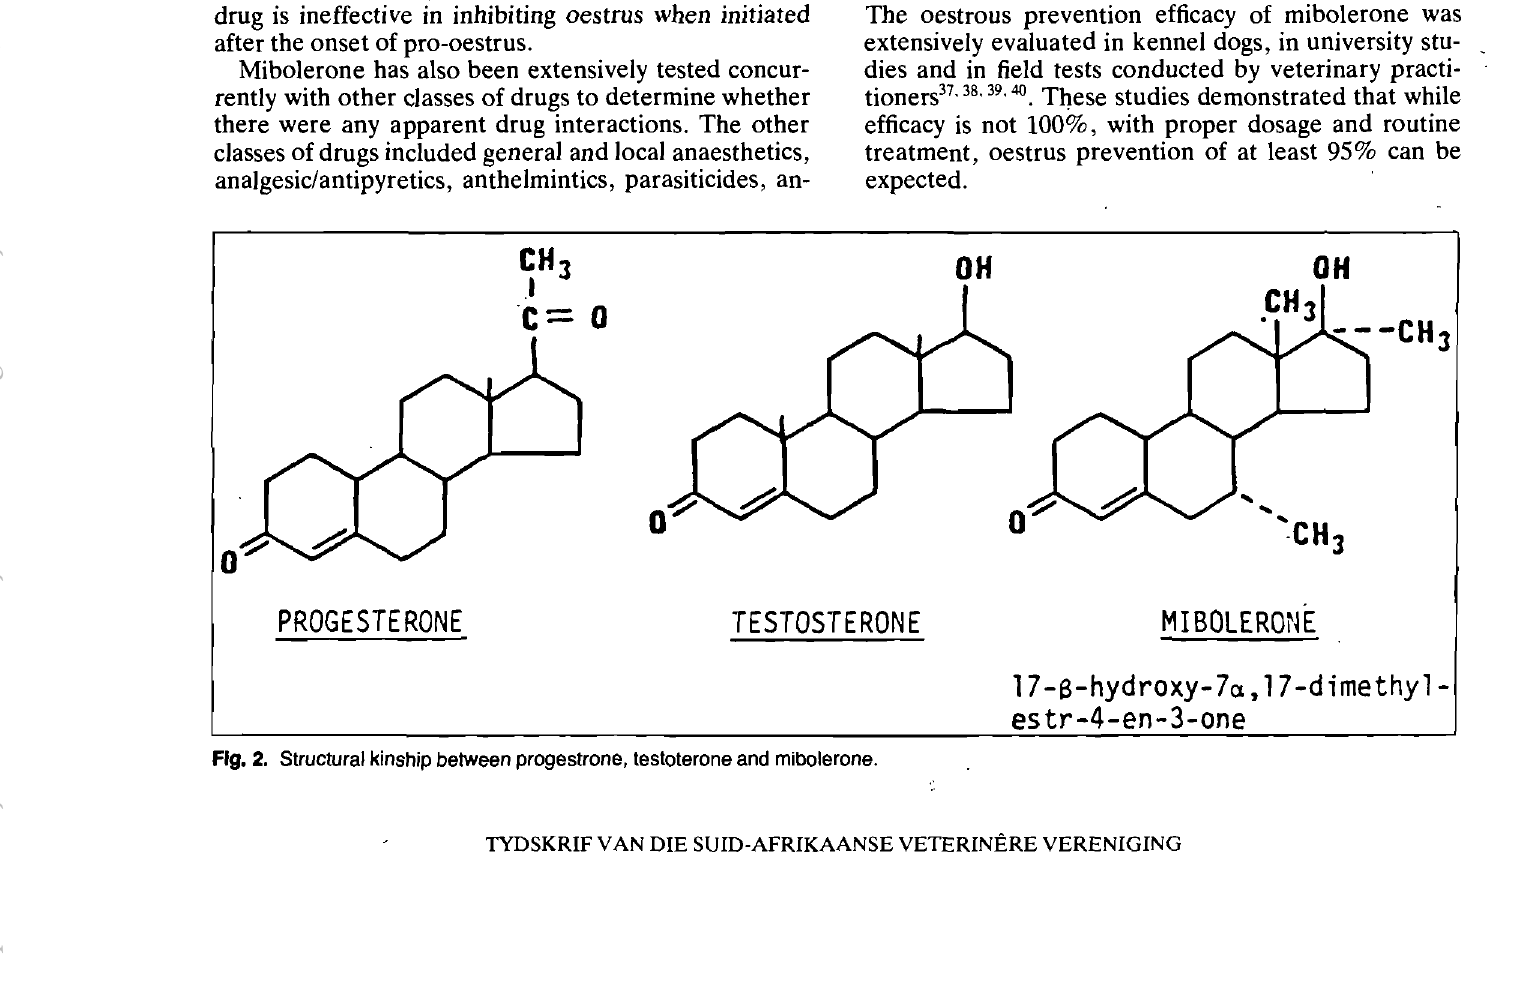
FIg. 2. Structural kinship between progestrone. testoterone and mibolerone. TYDSKRIF VAN DIE SUID-AFRIKAANSE VETERINERE